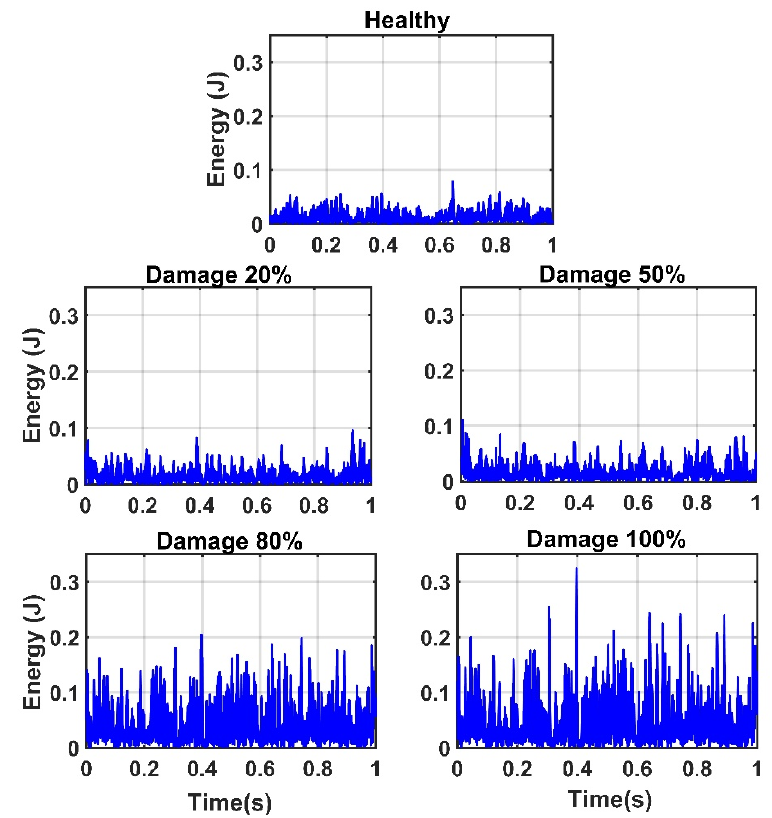
Figure 9. The energy of IMFs of the sensor-10 estimated by the proposed model for the healthy state and different damage levels of the truss.